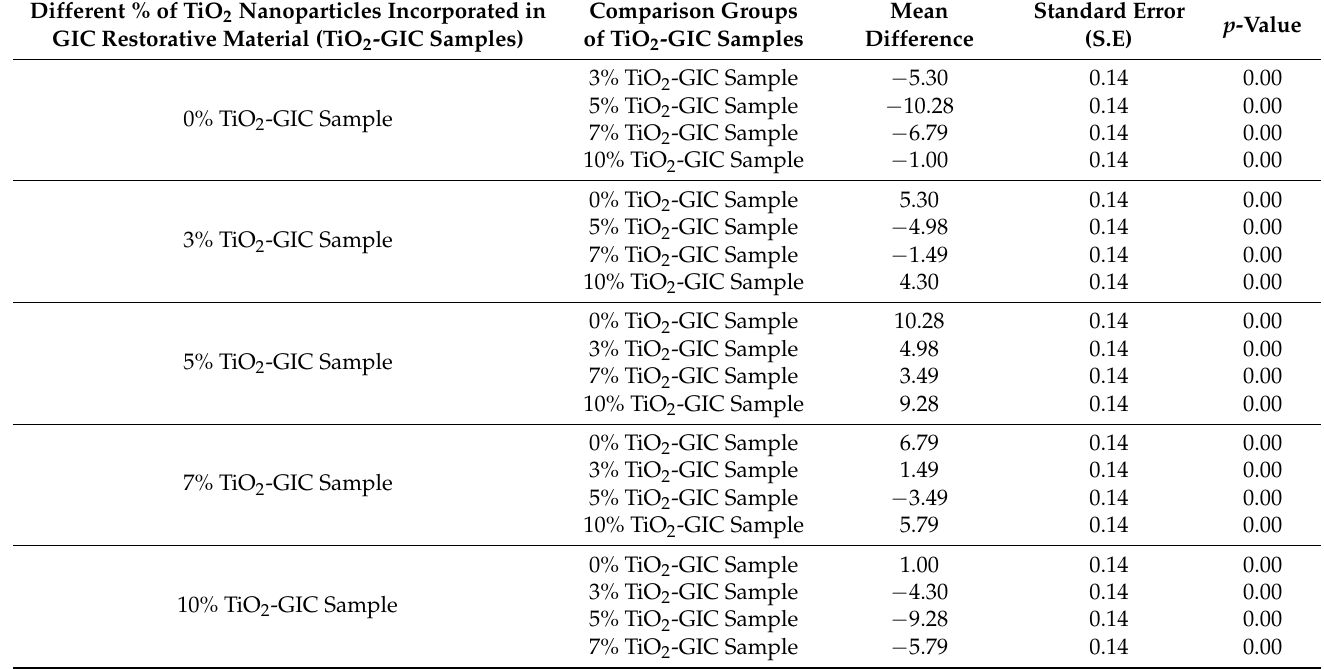
Figure 11. Flexural strength analysis of GIC restorative material containing various concentrations of TiO 2 nanoparticles. Table 4. Inter-group comparisons of flexural strength of GIC restorative material containing various concentrations of TiO 2 nanoparticles.